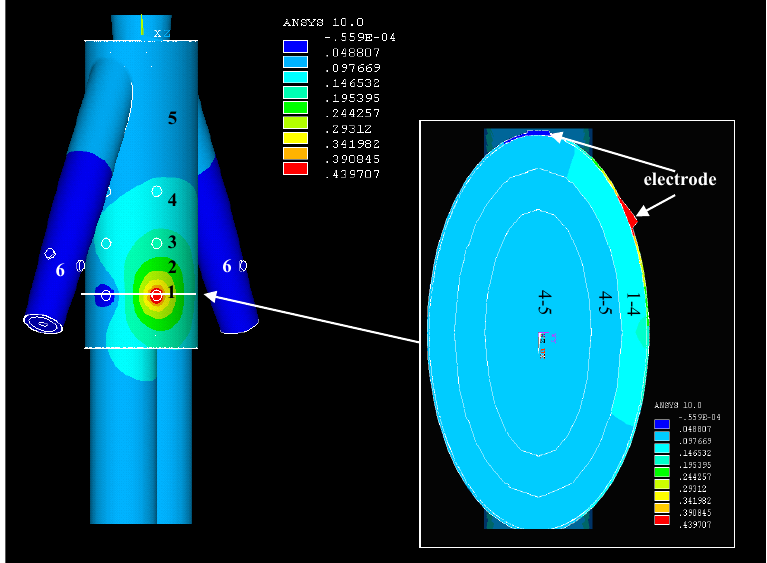
Figure 5. The potential distribution when signal transmits from